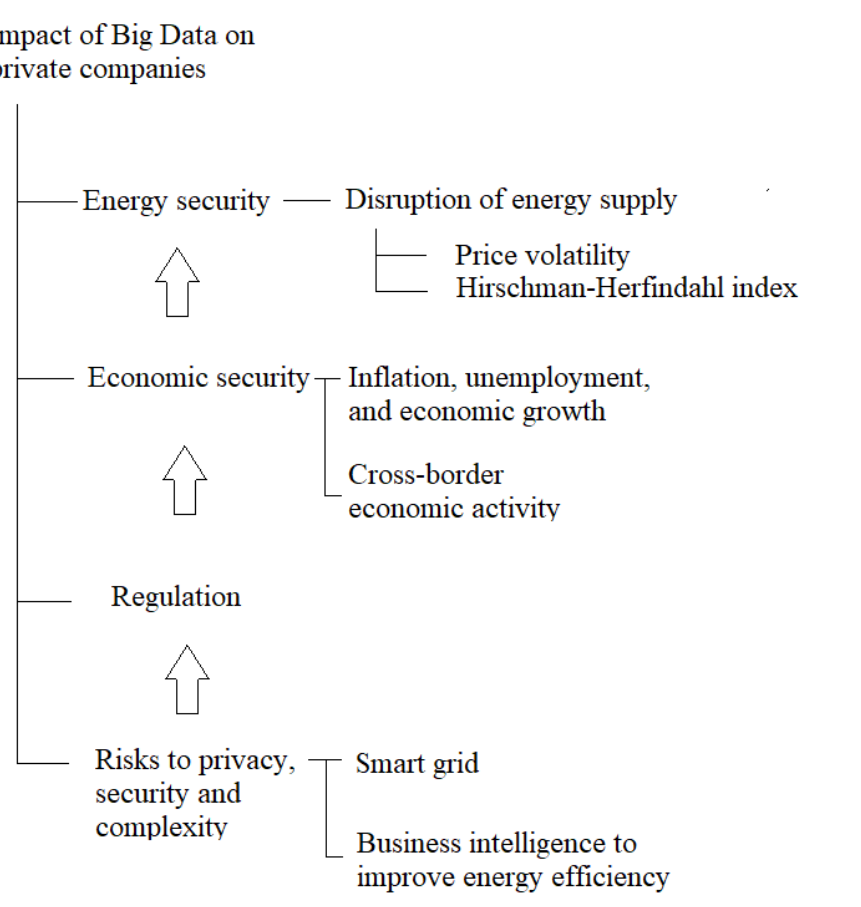
Figure 1. Flowchart diagram: Drivers of the Impact of Big Data on private companies and factors affecting energy security.